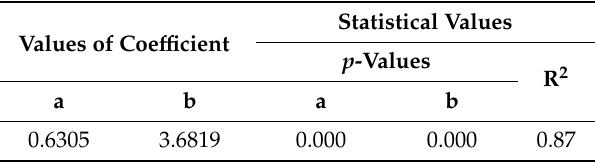
Table 6. Parameters of the equation representing exact agreement between registered and simulated linolenic acid content in the seeds of winter oilseed rape grown in Łagiewniki in 2006–2008. Values of Coe ffi